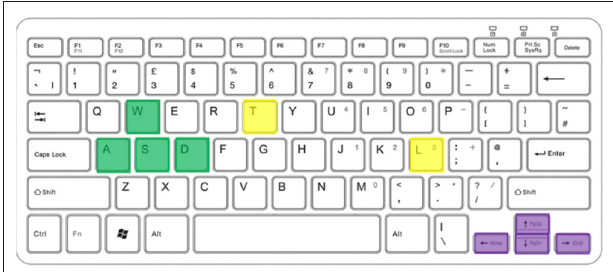
FIGURE 2 | Keyboard keys used to control the drone: in yellow T and L for take-off and landing; in purple the arrows to direct the drone’s gaze; in green the WASD keys for